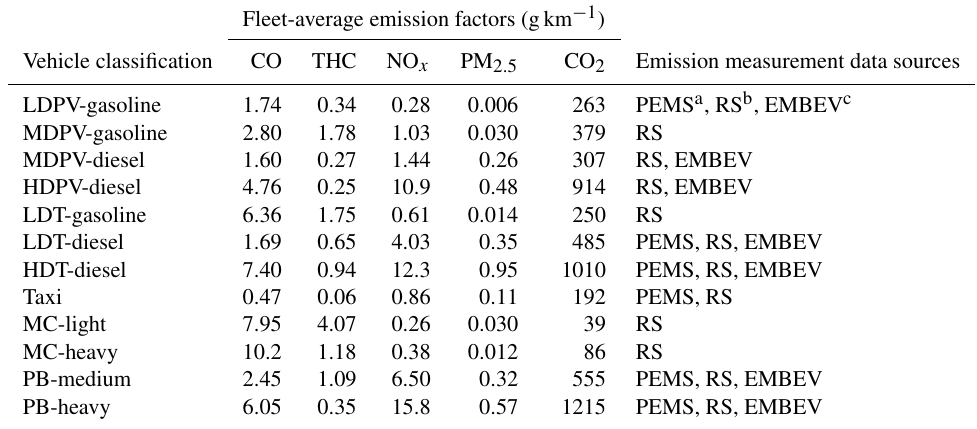
Table 4. Estimated fleet-average emission factors under real-world driving conditions.